Question: What visual encoding does this figure use to show its data?
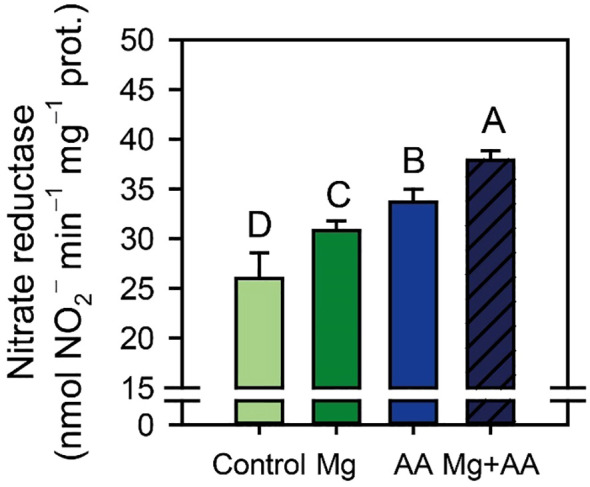
Answer: bar